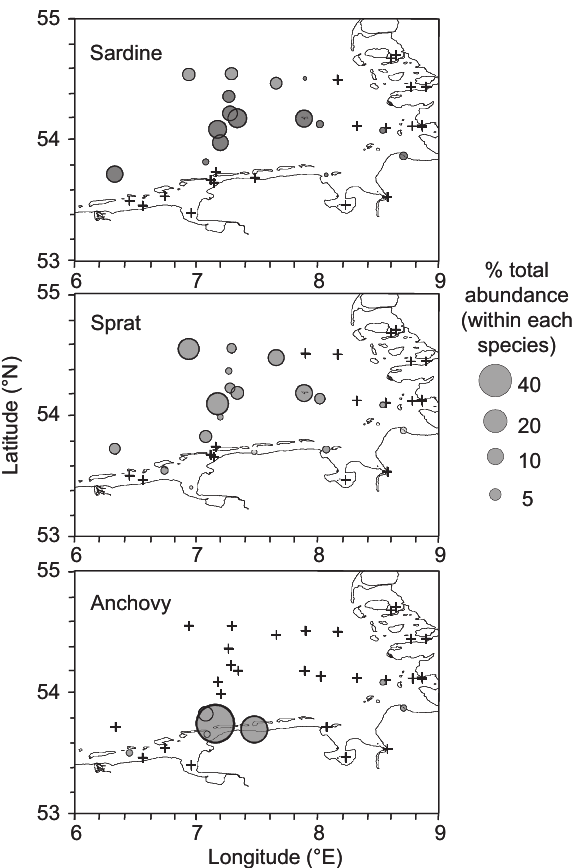
F IG . 4. – Relative abundance of clupeiform larvae within each spe- cies in the German Bight, circles indicate percentage of total abun- dance, crosses indicate stations without larvae (Panel A) sardine, abundance ranged from 0.6 to 45.3 larvae m -2 ; (Panel B) sprat, abundance ranged from 0.2 to 24.7 larvae m -2 ; (Panel C) anchovy, abundance ranged from 0.02 to 5.8 larvae m -2